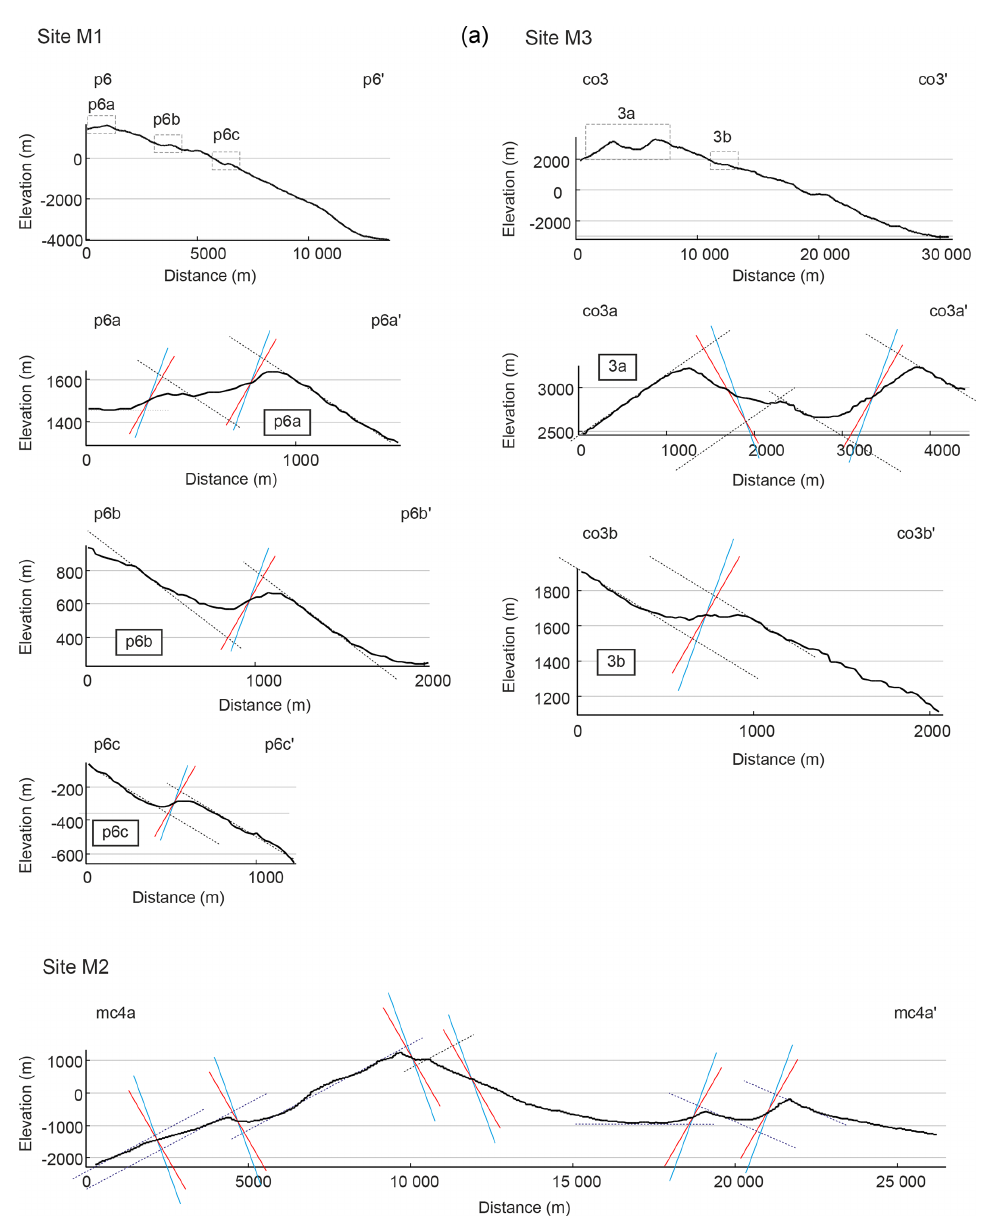
Figure 8. (a) Determination of fault traces (continuous lines) from topographic slope around fault (dotted line) measured at the three Martian study sites, assuming fault dips of 60 ◦ (red) and 70 ◦